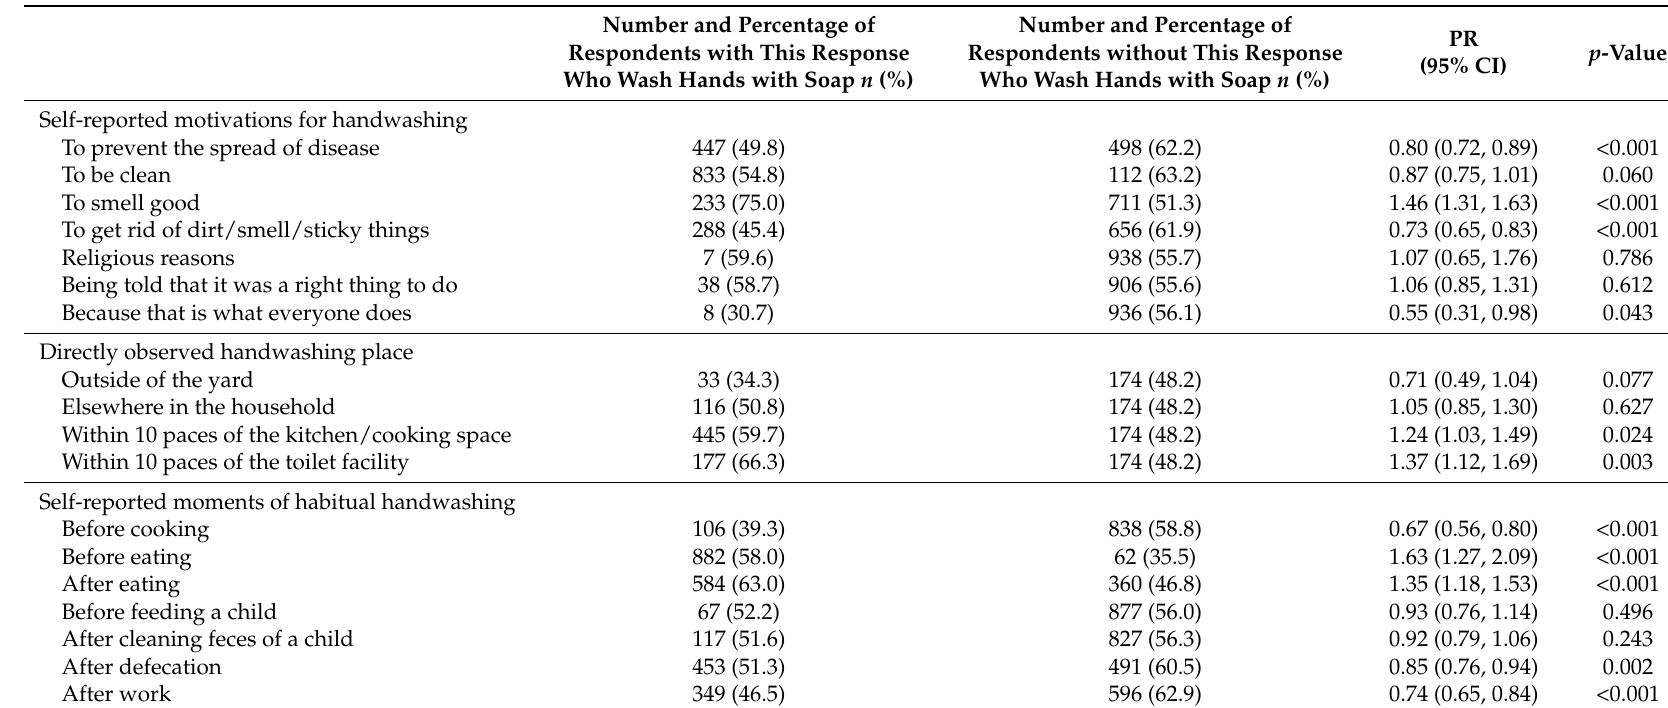
Table 3. Unadjusted generalized linear models (GLM) regression (Family: Poisson, Link: Log) of handwashing with soap by selected variables, n = 1696.